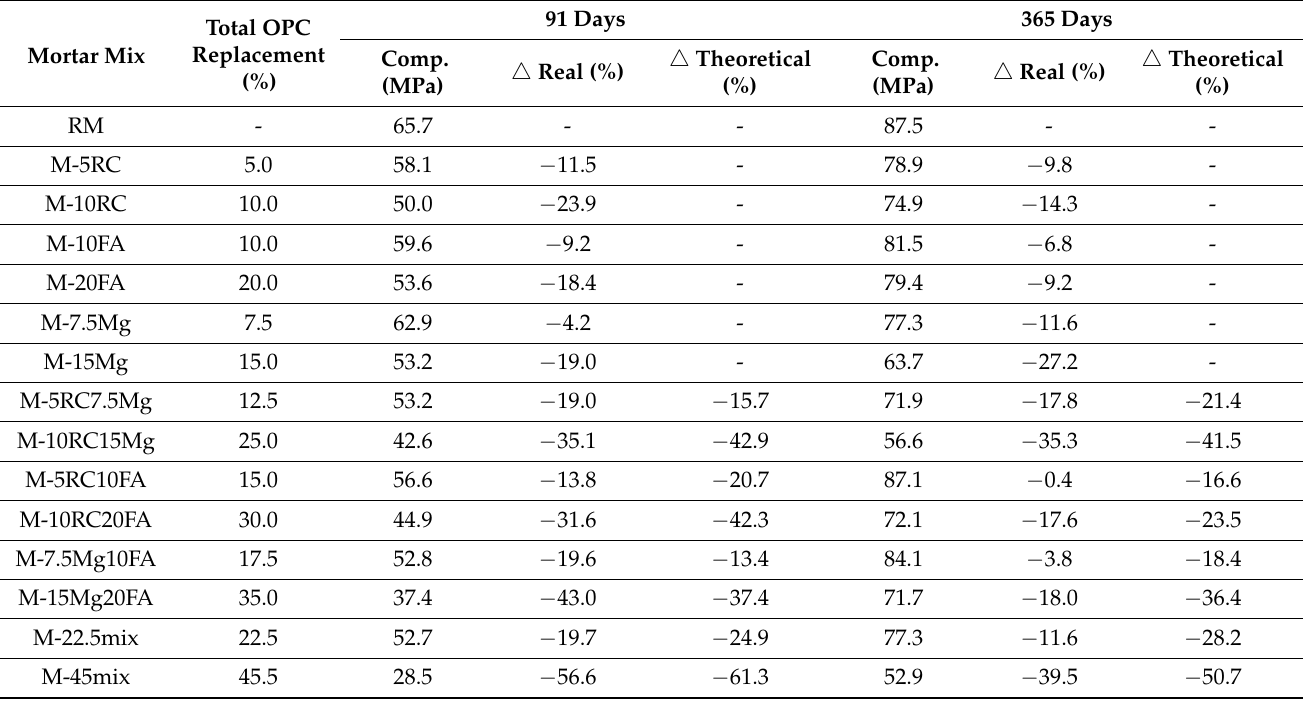
Table 5. Compressive strength at 91 and 365 days of